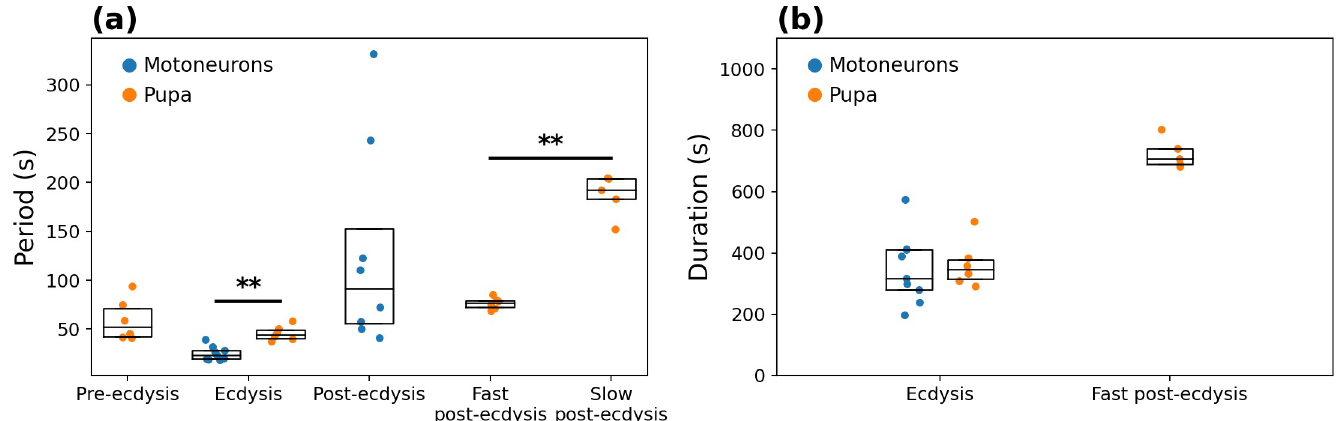
Fig 11. Behavioral metrics. Metrics and comparison of motoneuronal activity (n = 9) and pupal behavior (n = 6). (a) Period of the characteristic motor patterns of each of the ecdysial phases. (b) Duration of the ecdysis and of the fast post-ecdysis phase.